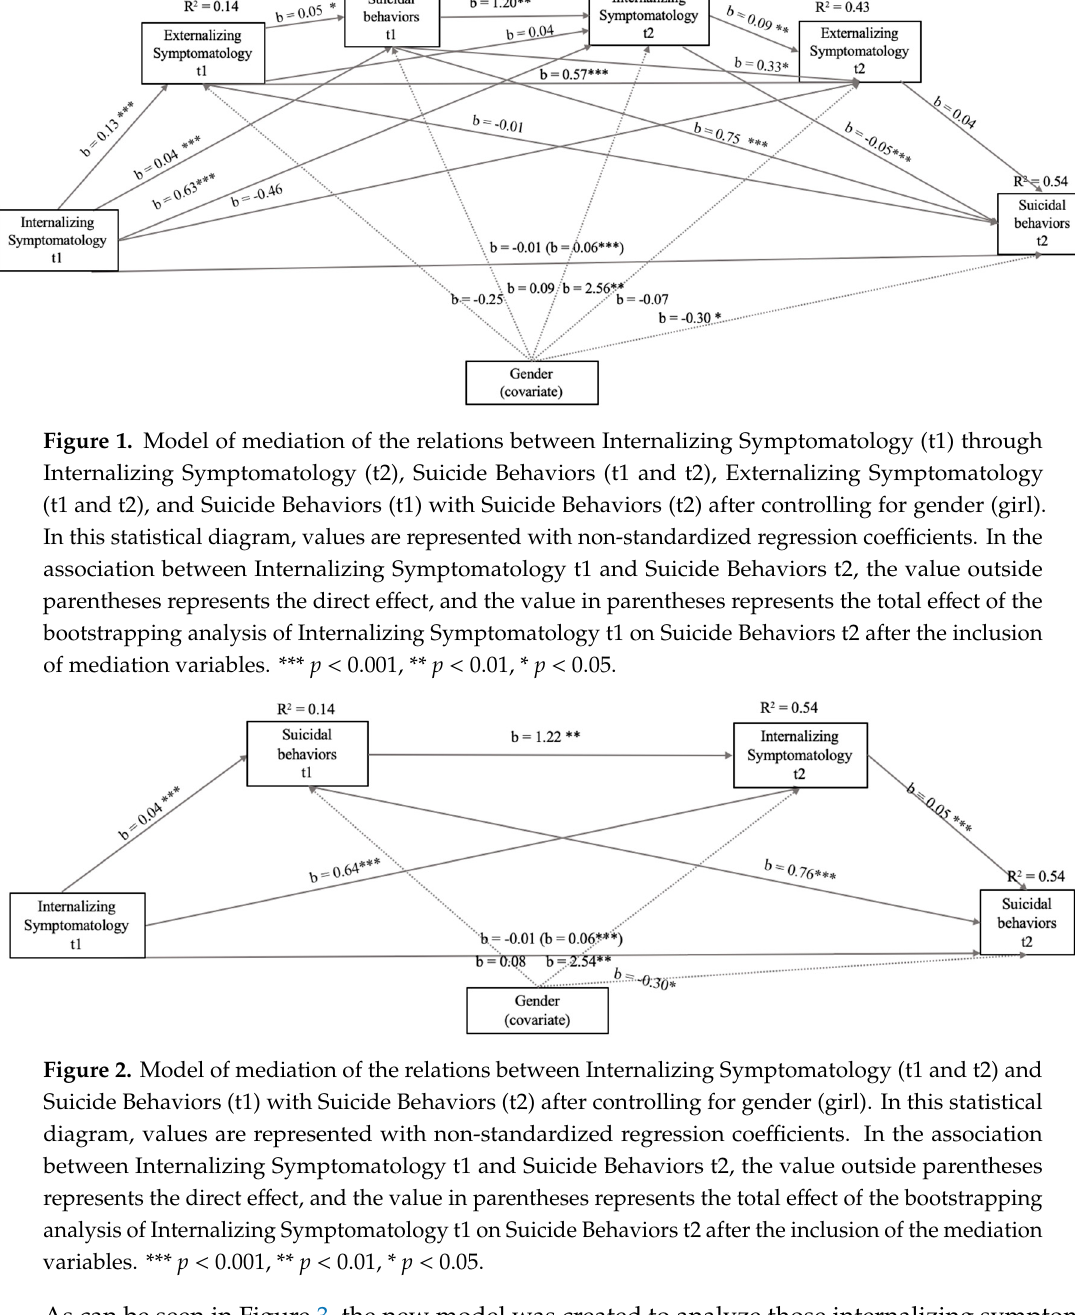
Figure 2. Model of mediation of the relations between Internalizing Symptomatology (t1 and t2) and Suicide Behaviors (t1) with Suicide Behaviors (t2) after controlling for gender (girl). In this statistical diagram, values are represented with non-standardized regression coefficients. In the association between Internalizing Symptomatology t1 and Suicide Behaviors t2, the value outside parentheses represents the direct effect, and the value in parentheses represents the total effect of the bootstrapping analysis of Internalizing Symptomatology t1 on Suicide Behaviors t2 after the inclusion of the mediation variables. *** p < 0.001, ** p < 0.01, * p < 0.05.